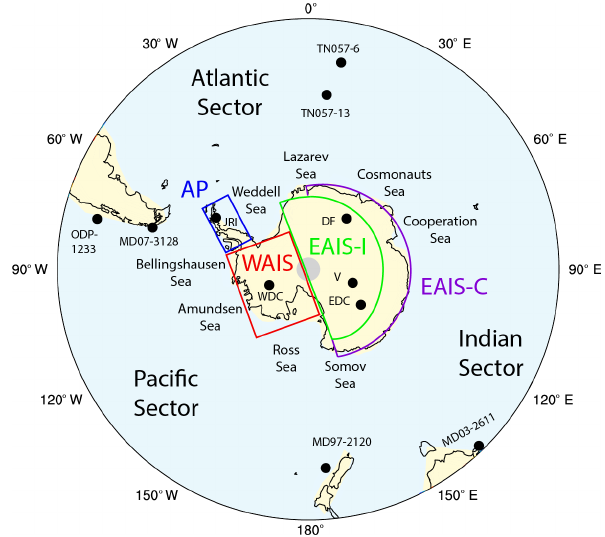
Figure 1. Polar stereographic view of Antarctica and the Southern Ocean (maximum latitude of 35 ◦ S). The colours indicate the land and ocean mask of the TraCE-21ka simulation (yellow and light blue, respectively). The continental regions, namely the Antarc- tic Peninsula (AP), the West Antarctic Ice Sheet (WAIS), the East Antarctic Ice Sheet interior (EAIS-I), and the East Antarctic Ice Sheet coastal region (EAIS-C), are outlined in the coloured boxes (blue, red, green, and purple, respectively). The locations of the Antarctic ice core and marine sediment records used in this anal- ysis are indicated by the black